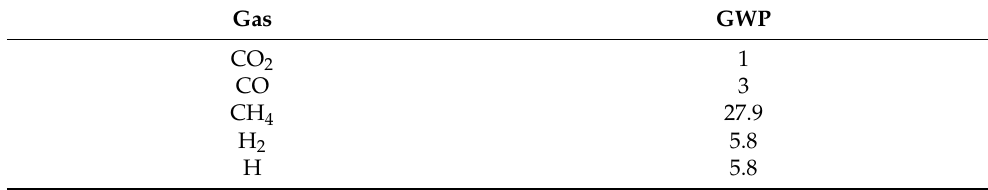
Table 3. GWP (lifetime 100